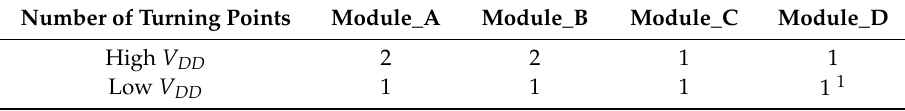
Table 3. The comparison about characteristics of v DS over number of turning points. Number of Turning Points Module_A Module_B